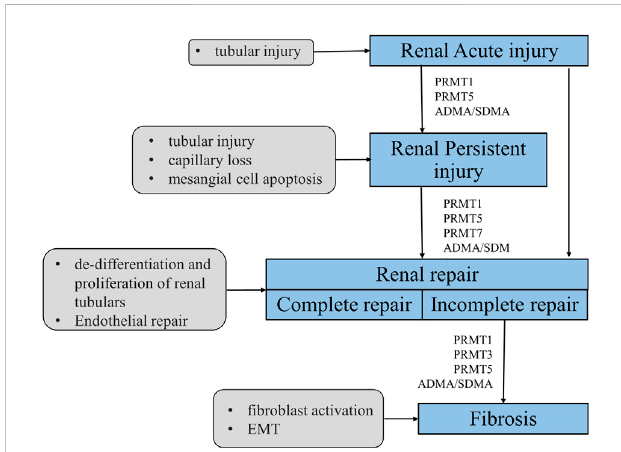
FIGURE 1 Mechanism of PRMTs-mediated renal injury, repair and renal fi brosis.Afteraminorinjury,thekidneycanrepairitself(completerepair); however, when severe injury or injury persists, the self-repair mechanism of the kidney cannot resist the external damage, it will tend to develop fi brosis (incomplete repair). PRMTs are widely involved in the process of kidney injury, repair and fi brosis. PRMT1 and ADMA/ SDMA are involved in acute and chronic kidney injury, repair and fi brosis. PRMT5mainlyplaysaroleinacutekidneyinjuryandrepair,andPRMT7is currently described only in the repair